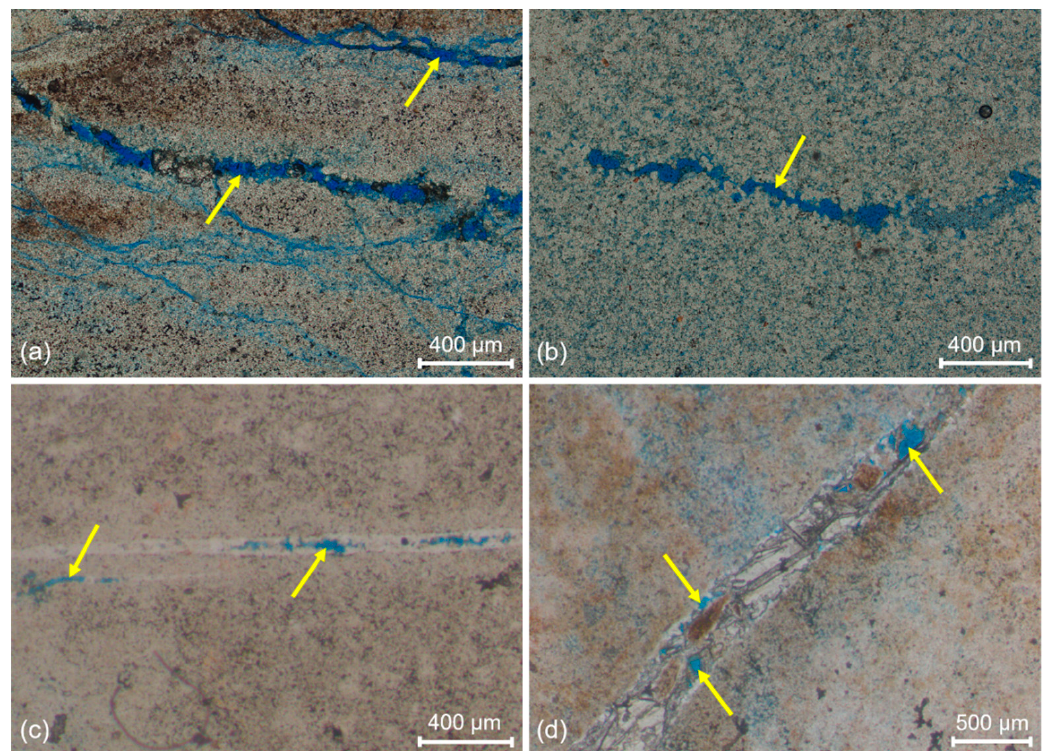
Figure 11. Dissolution fractures in thin sections. ( a ) Fractures in Well R12, depth 3105.18 m (10,187.60 ft). ( b ) Fractures in Well R12, depth 3112.35 m (10,211.12 ft). ( c ) Fractures in Well R17, depth 2764.60 m (9070.21 ft). ( d ) Fractures in Well R17, depth 2764.00 m (9068.24 ft). The directions of these thin sections are vertical to the wellbore. The minerals dissolved in these filled fractures are